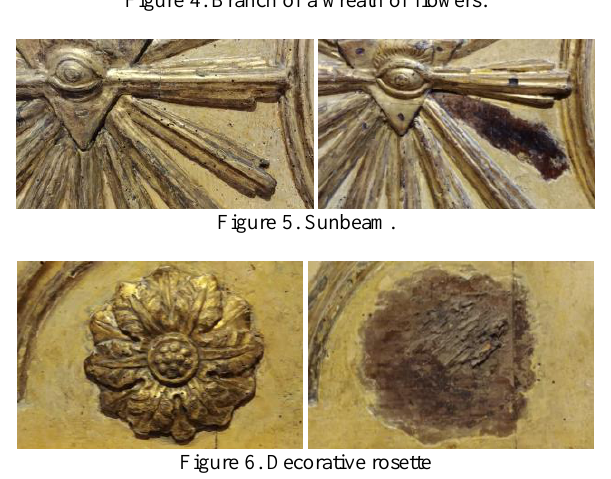
Figure 6. Decorative rosette